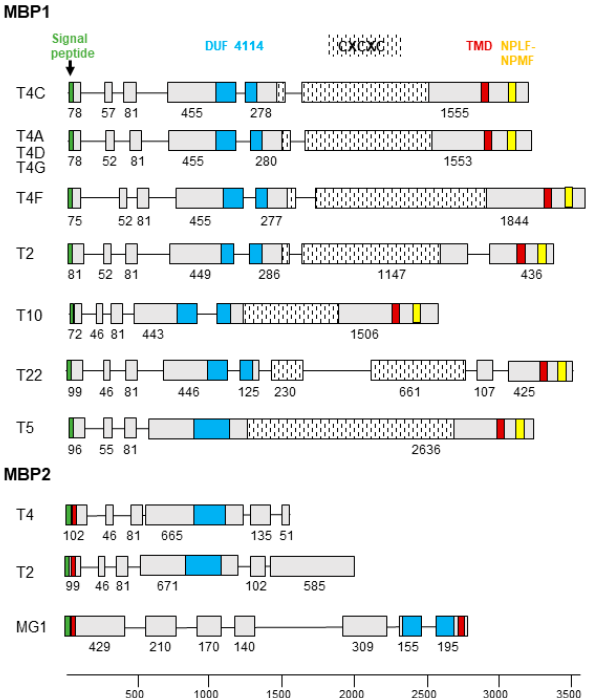
Figure 3. MBP gene structure. Schematic drawing of the exon/intron structure of the MBP1 and MBP2 genes of Acanthamoeba . Exons are shown as boxes with the number of nucleotides below, introns as a line. The signal peptide, DUF 4114, CXCXC repeat coding region, transmembrane domain (TMD), and cell signalling NPLF motif are colour coded and shown at the top.